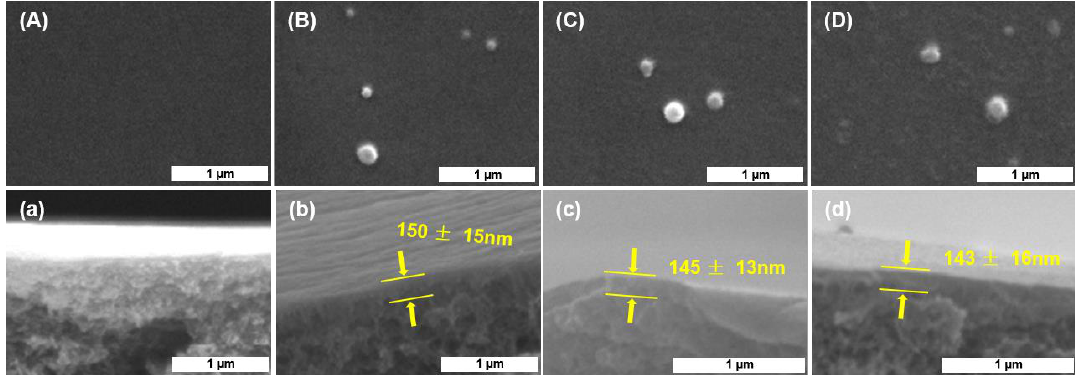
Figure 3. The surface morphology of ( A ) PES, ( B ) TAEA-PIP0, ( C ) TAEA-PIP0.01, ( D ) TAEA-PIP0.02 membranes; Cross-sectional morphology of ( a ) PES, ( b ) TAEA, ( c ) TAEA-PIP0.01, ( d ) TAEA-PIP0.02 membranes.